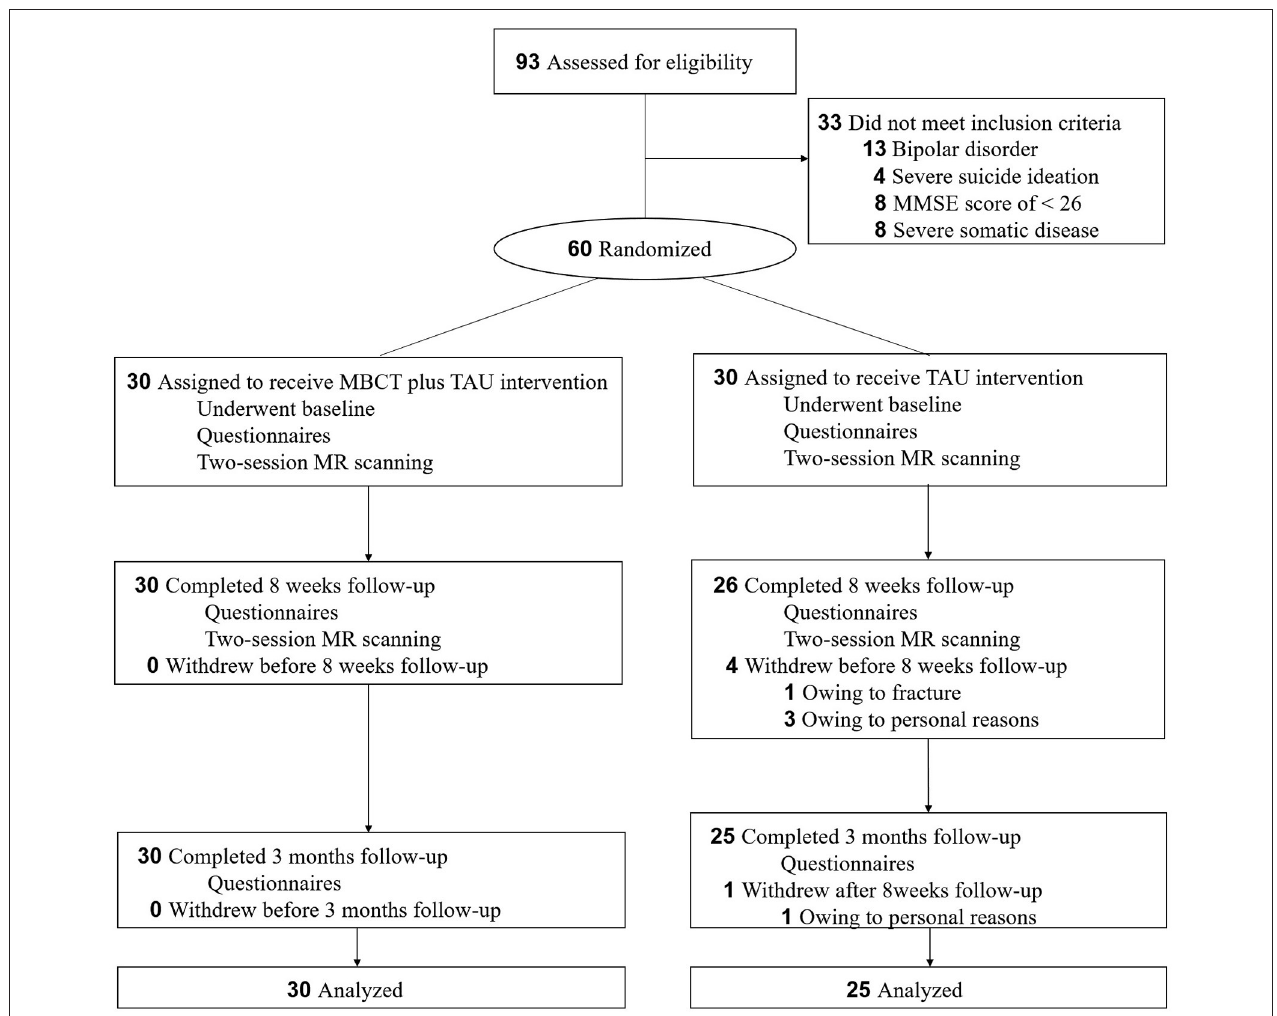
FIGURE 1 | Flow chart of the